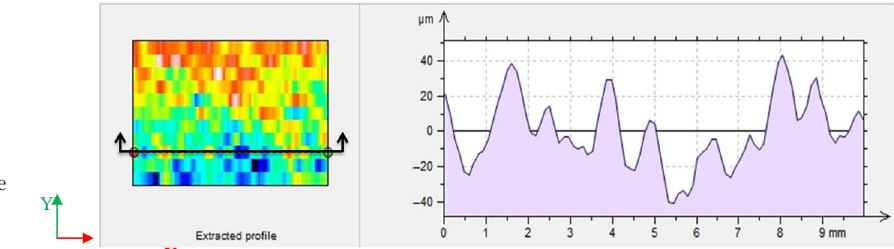
Figure 3. Linear pro fi le of sample A-41, top surface in X-Z plane with roughness of 16.8 m m